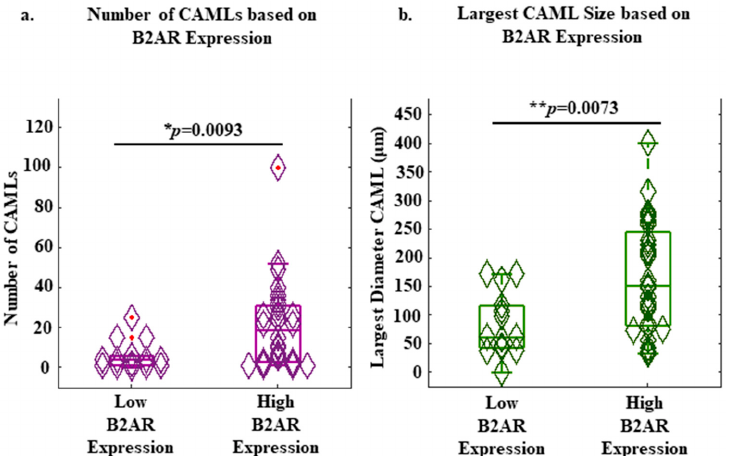
Figure 3. Relationship of B2AR expression of the CAMLs in relation to CAML number and the largest CAML in circulation. ( a ) Whisker plots of patients’ CAML numbers based on high/low expression of B2AR. Wilcoxon rank-sum (* p = 0.0093). Red dots = data outliers. ( b ) Whisker plots of the largest-diameter CAML from each patient’s sample based on high/low expression of B2AR. Wilcoxon rank-sum (** p = 0.0073).